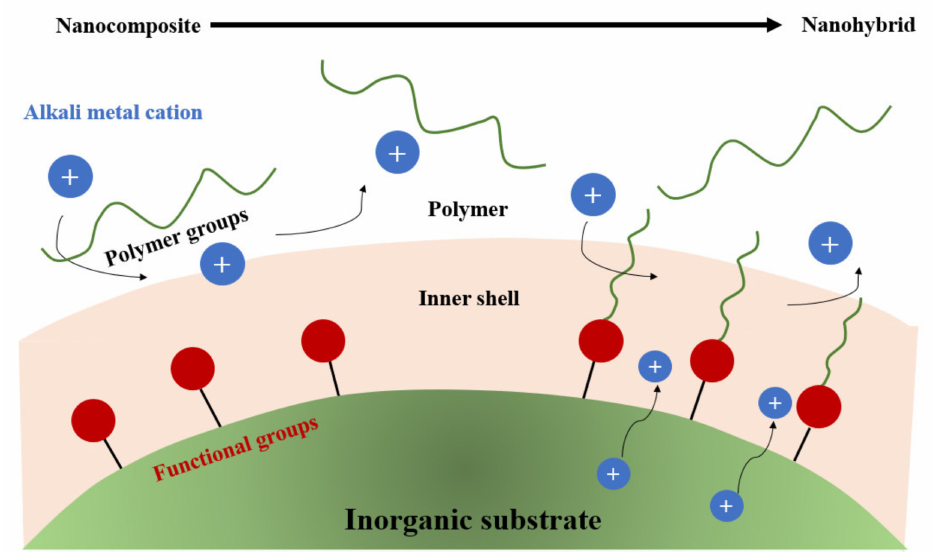
Figure 6. Challenges and opportunities for CPEs and HPEs